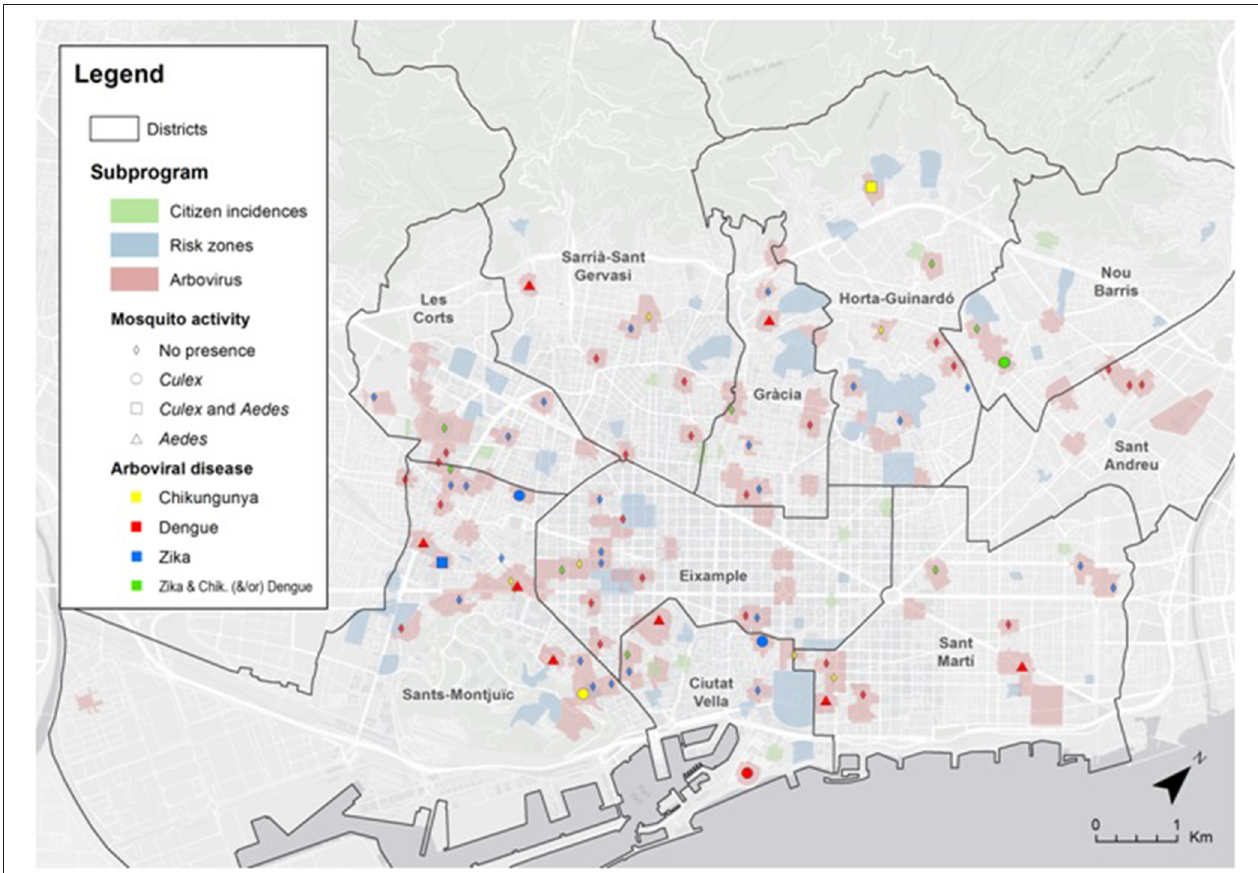
FIGURE 5 | Map of the city of Barcelona with the spatial location of the different arbovirosis cases and the results of the entomological inspections. Risk zones: monthly surveillance and control vector zones. Citizen incidences: Notices regarding mosquito problems that citizens have indicated during the study